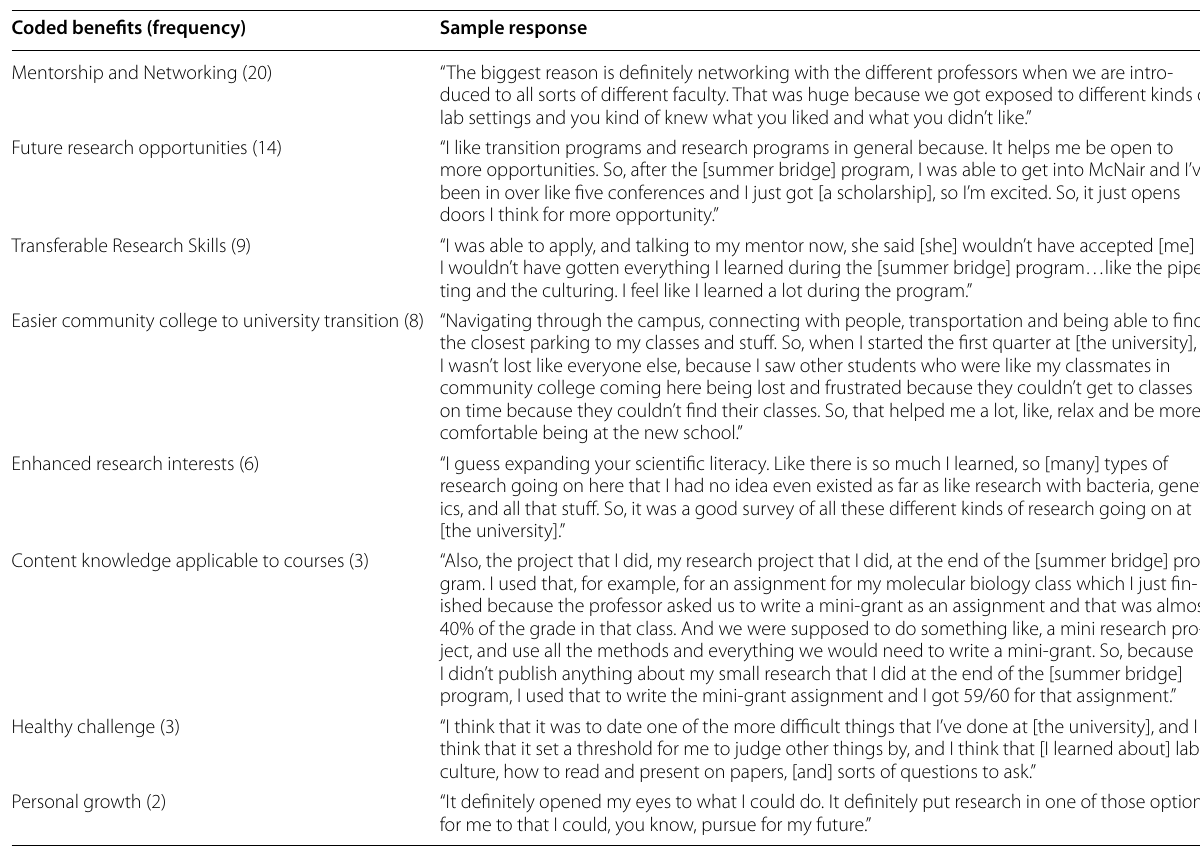
Table 3 Benefits of participating in the summer bridge program. In an interview to provide formative feedback on the program , participants articulated the benefits they obtained. Coded benefits are in order from highest to lowest frequency, and sample responses are provided for each code. Because many participants described multiple benefits, the number of coded segments ( n exceeds the number of participants in the sample ( n =